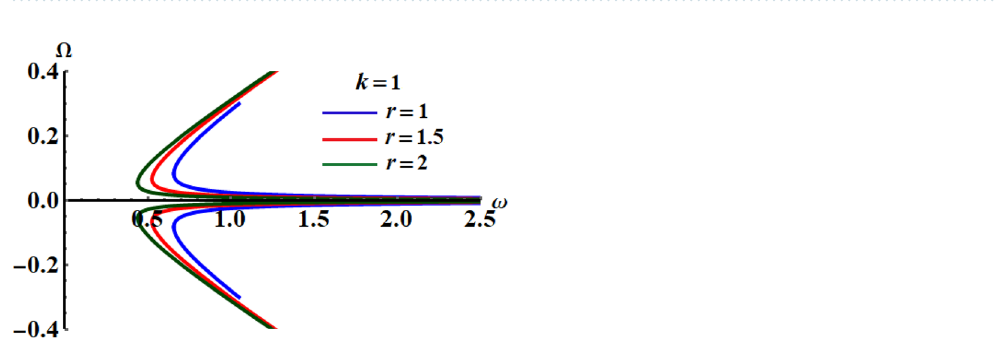
Figure 3. Reveals the NS at k = 1 and r = 1 .